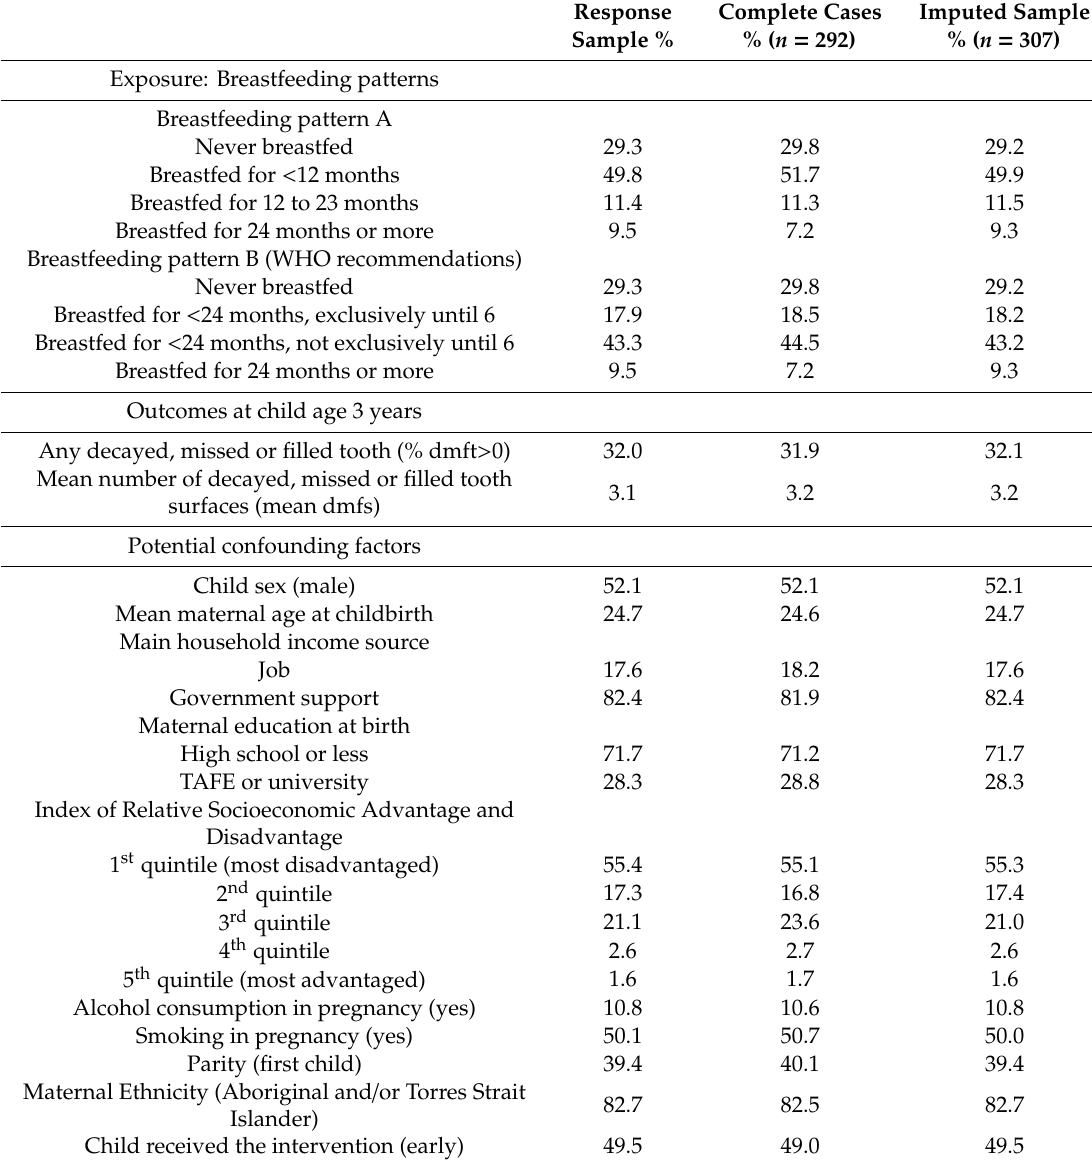
Table 1. Characteristics of the study